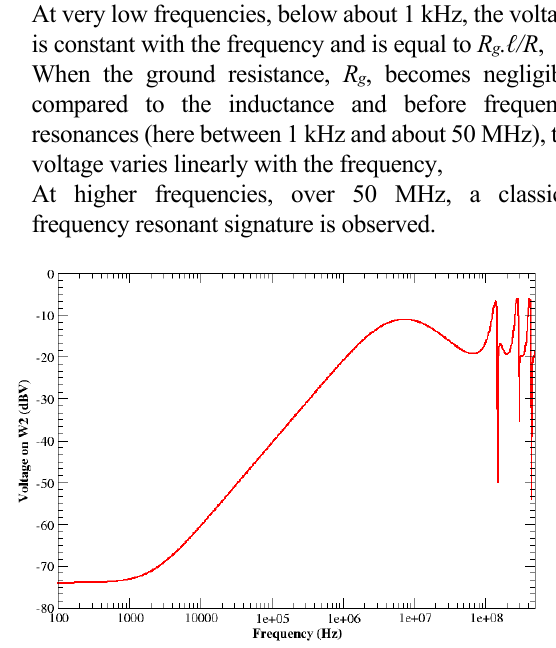
FIGURE 20. Voltage V 2ref induced on W2 (bare wire with no shield at all) – Far end crosstalk